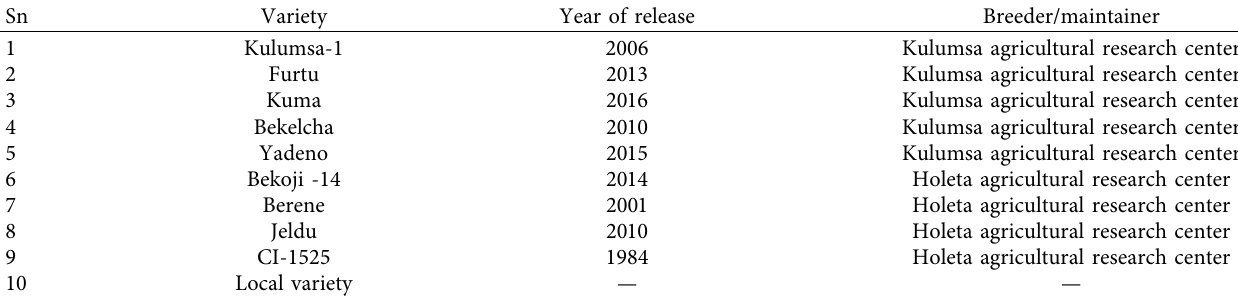
Table 1: List of experimental linseed varieties used at Lay Gayint in the 2019 and 2020 copping seasons.